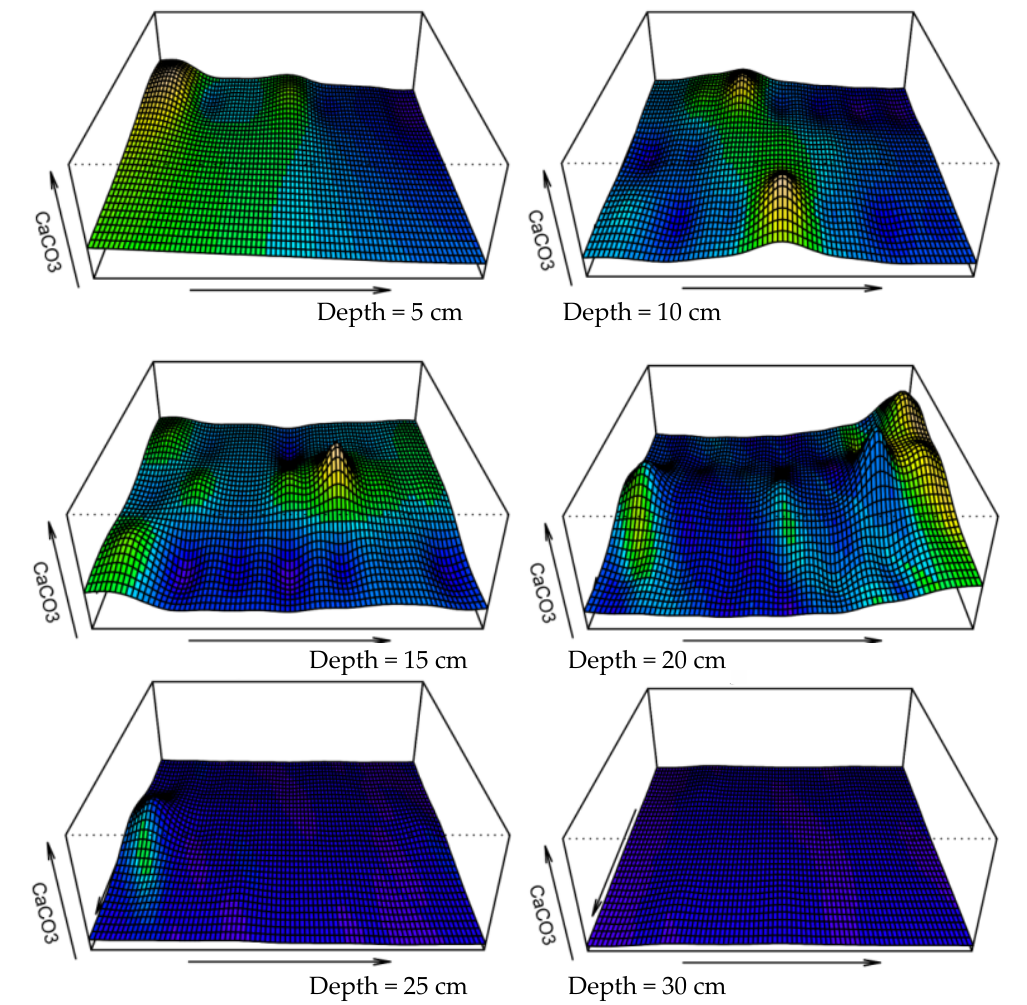
Figure 13. Three-dimensional distribution of calcium carbonate in the sandy soil foundation.